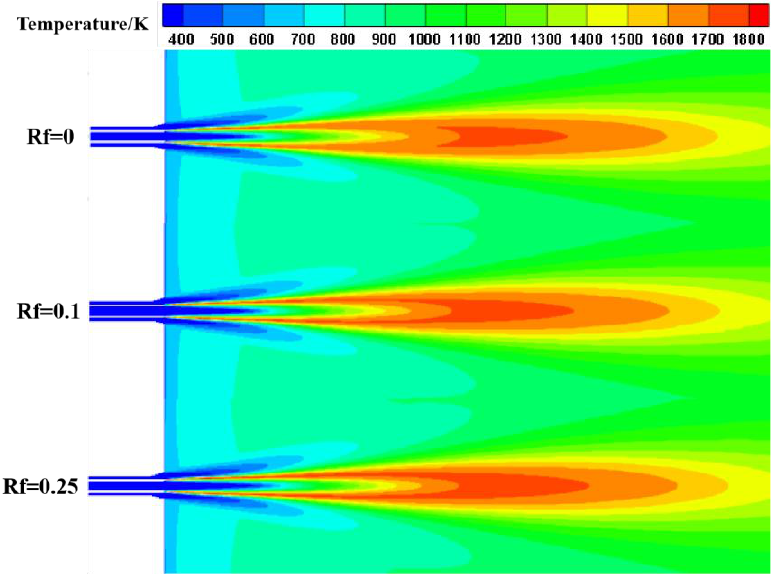
Figure 9. Temperature nephogram of high-temperature region under three hydrogen mixing ratio conditions.